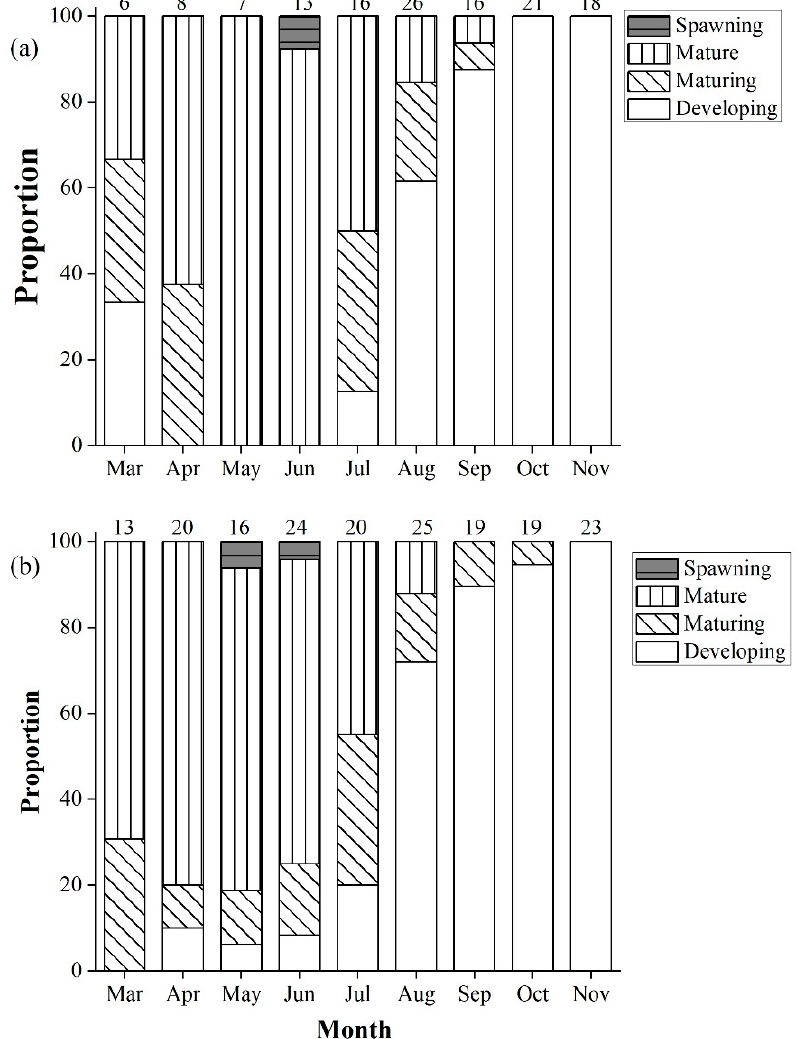
Figure 6. Monthly distribution of macroscopic gonad maturity stages in Pseudecheneis sulcatus male fish ( a ) and female fish ( b ) during the period from March to November 2016. Numbers on bars represent sample size.